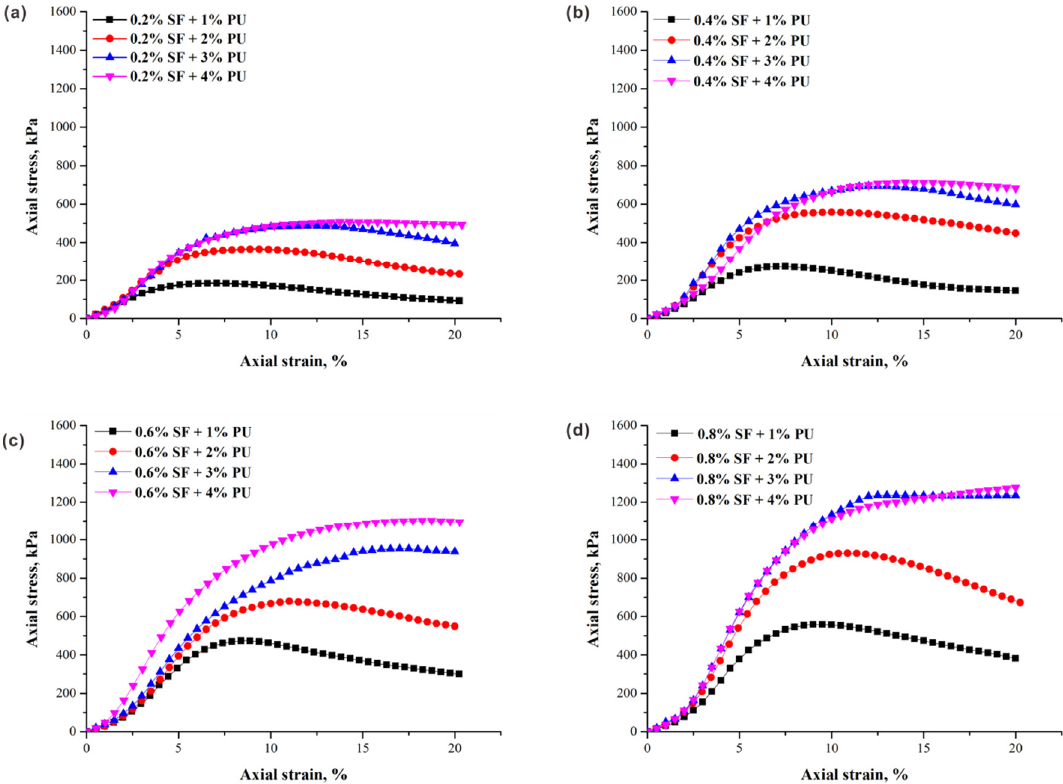
Figure 7. Typical stress–strain curves of specimens with varying PU content: ( a ) 0.2% fiber content; ( b ) 0.4% fiber content; ( c ) 0.6% fiber content; and ( d ) 0.8% fiber content at 1.5 g/cm 3 dry density.